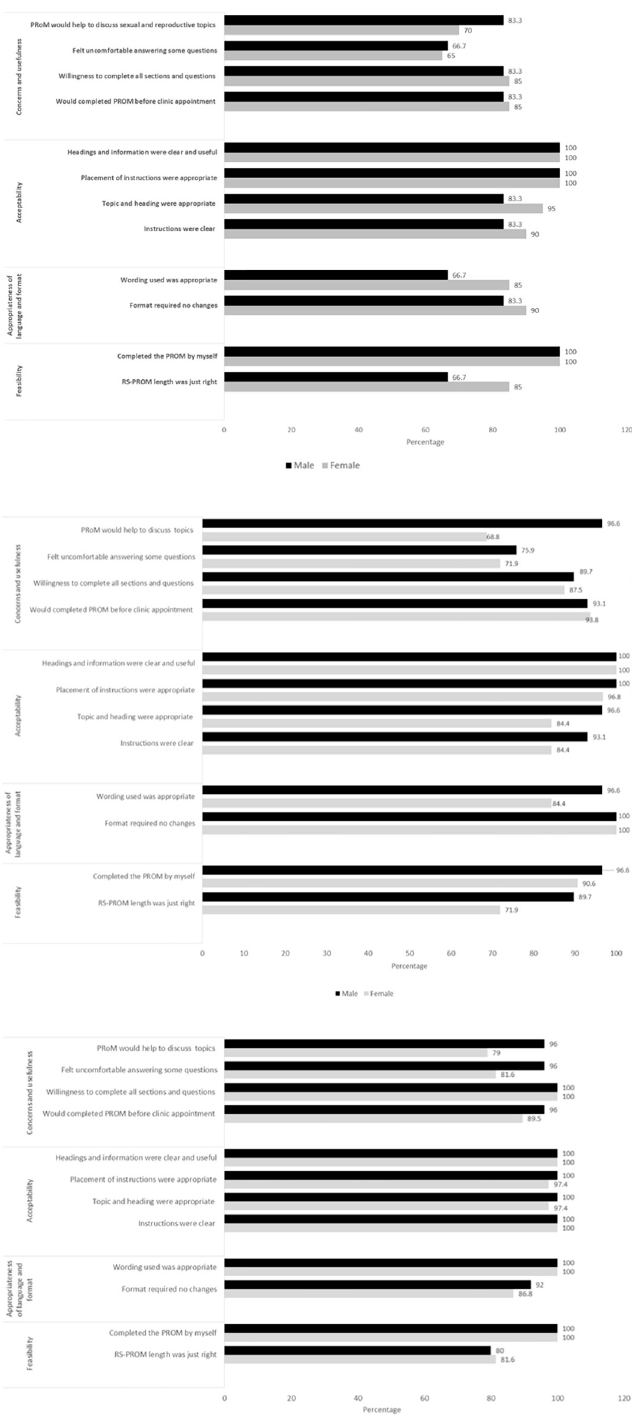
Fig 1. a. Paediatric childhood cancer survivor’s responses to themes in the RS-PROM. b. AYA cancer survivor’s responses to themes in the RS-PROM. c. Adult cancer survivor’s responses to themes in the RS-PROM.